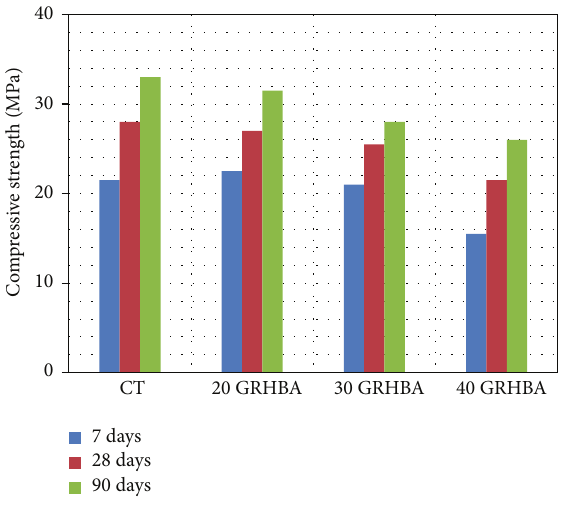
Figure 4: Compressive strength of SCC.